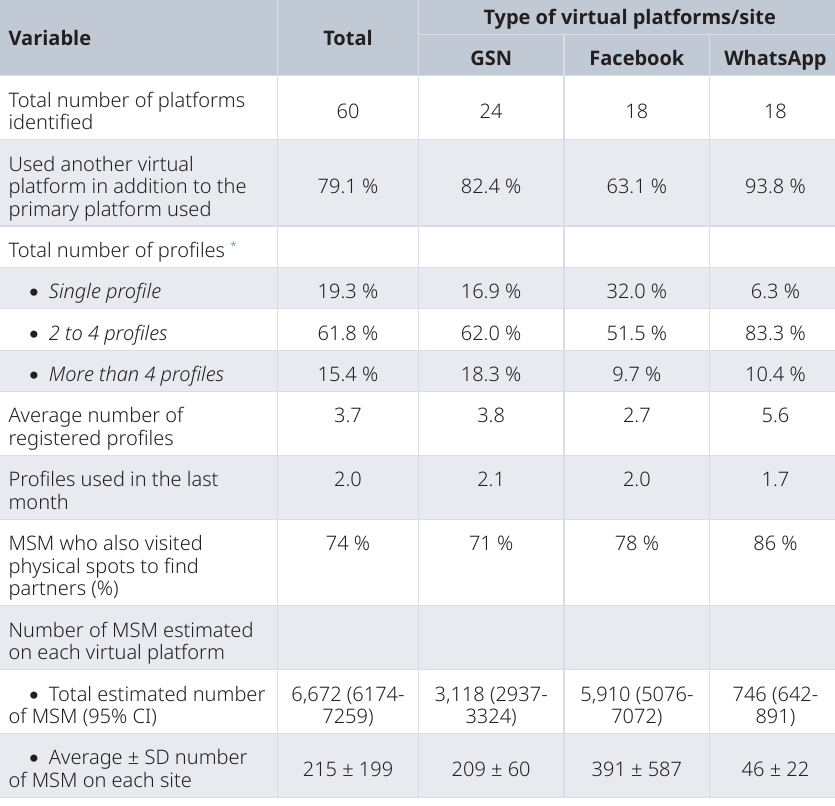
Table 1. Virtual platforms used by MSM in selected counties in Kenya,